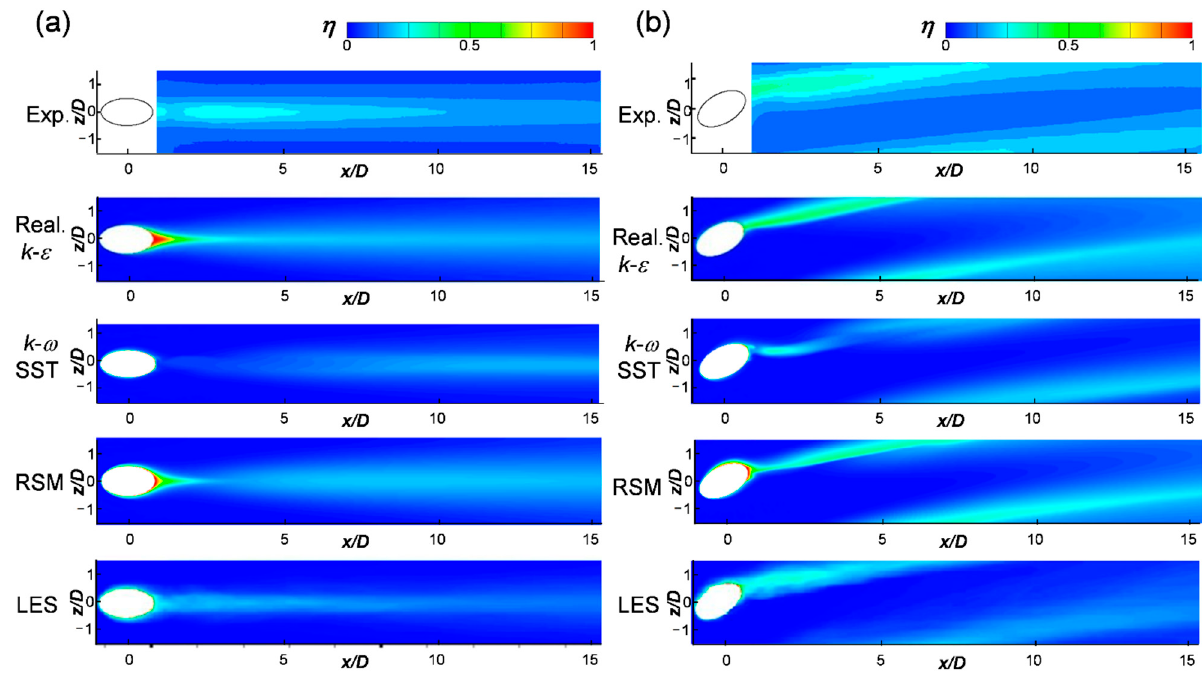
Figure 8. Local adiabatic film cooling effectiveness distributions at M = 1.0: ( a ) β = 0° and ( b ) β =